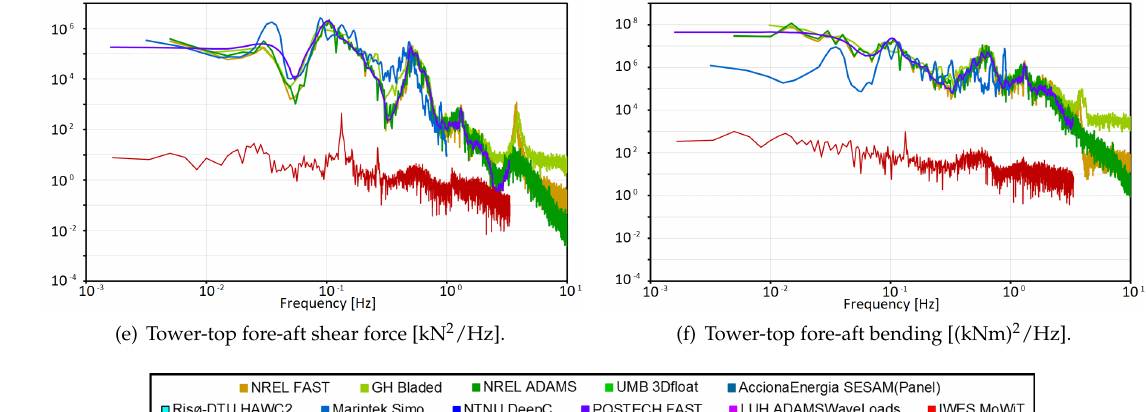
Figure 16. Aero-hydro-servo-elastic power spectra with irregular waves from LC 5.3, part